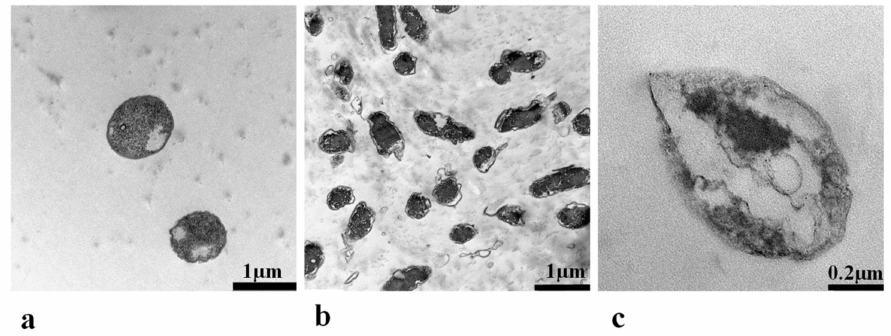
Figure 1. TEM images of Gluconacetobacter xylinus cellulose forming bacteria in pristine bacterial cellulose membranes. ( a )—rod-shaped bacteria; ( b )—ellipsoidal bacteria; ( c )—cell structure and wall aspect of G. xylinus